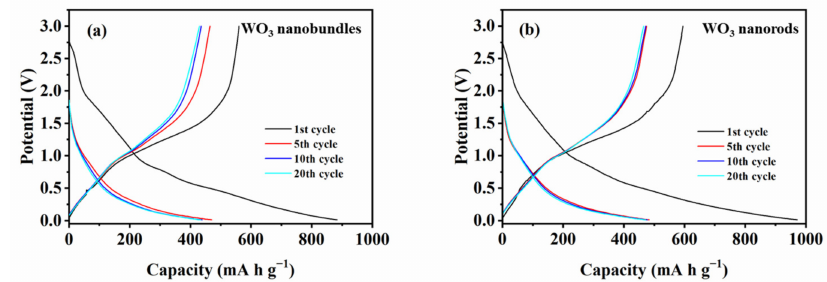
Figure 10. Galvanostatic discharge/charge curves of WO 3 nanostructures with different shapes at